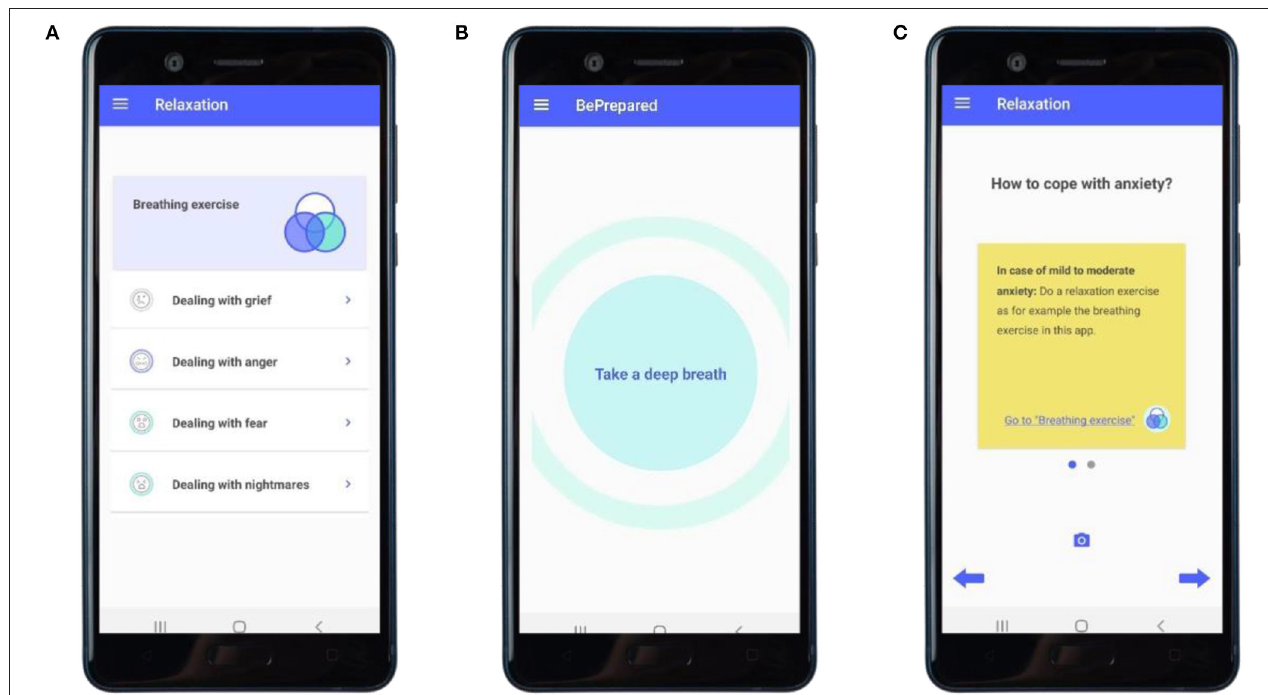
FIGURE 5 | “Relaxation”: skills-training with focus on emotions and behavior. (A) Overview of the exercises on breathing, and dealing with grief, anger, anxiety, and nightmares. (B) Examplary screen of the breathing exercise. (C) Examplary advice on how to cope with anxiety.